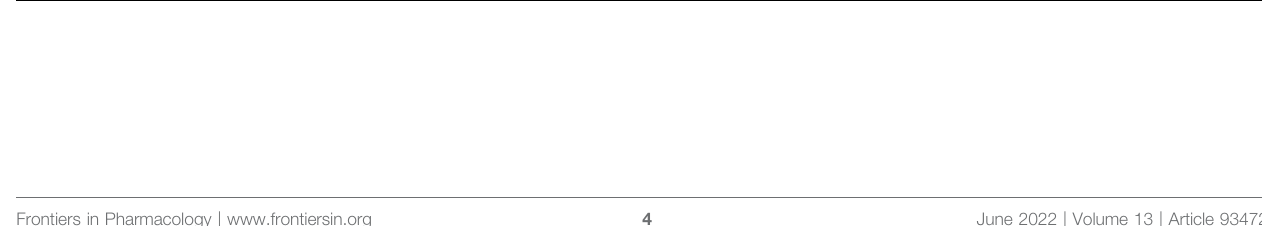
Frontiers in Pharmacology |